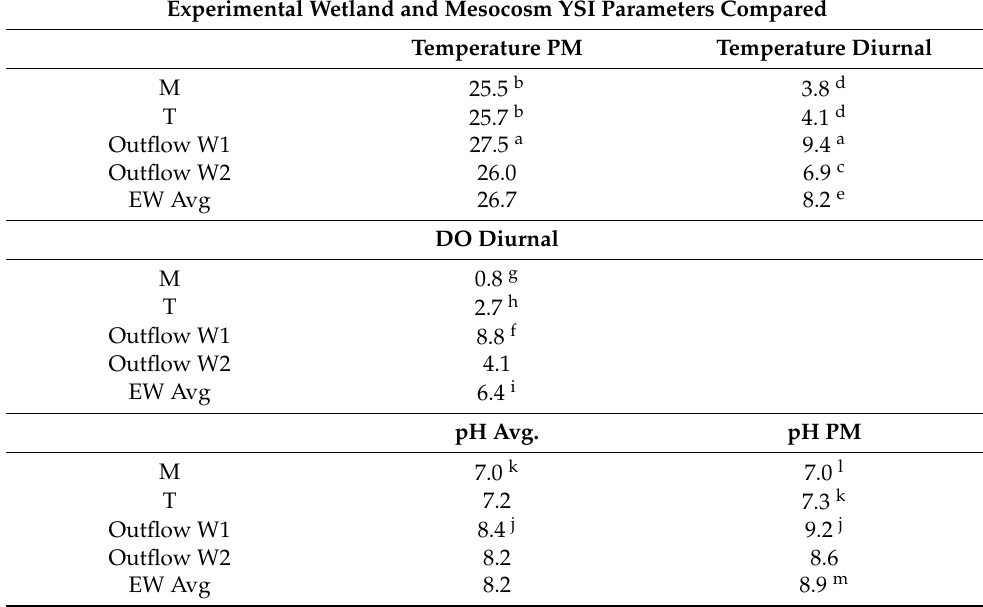
Table 8. The number of taxa found in samples by sample type and sample location. Experimental Wetland and Mesocosm YSI Parameters